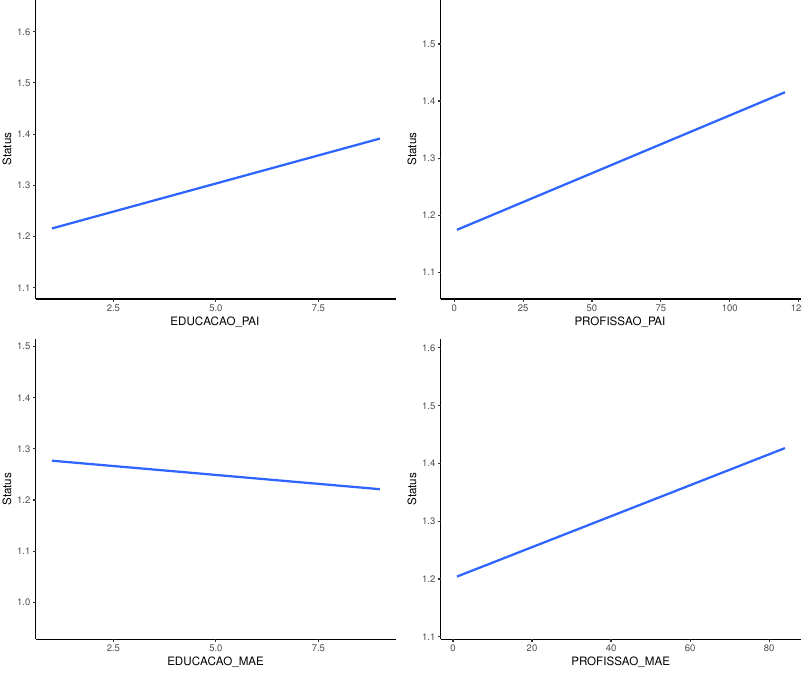
Figure 19. The correlation between father and mother’s education and profession and